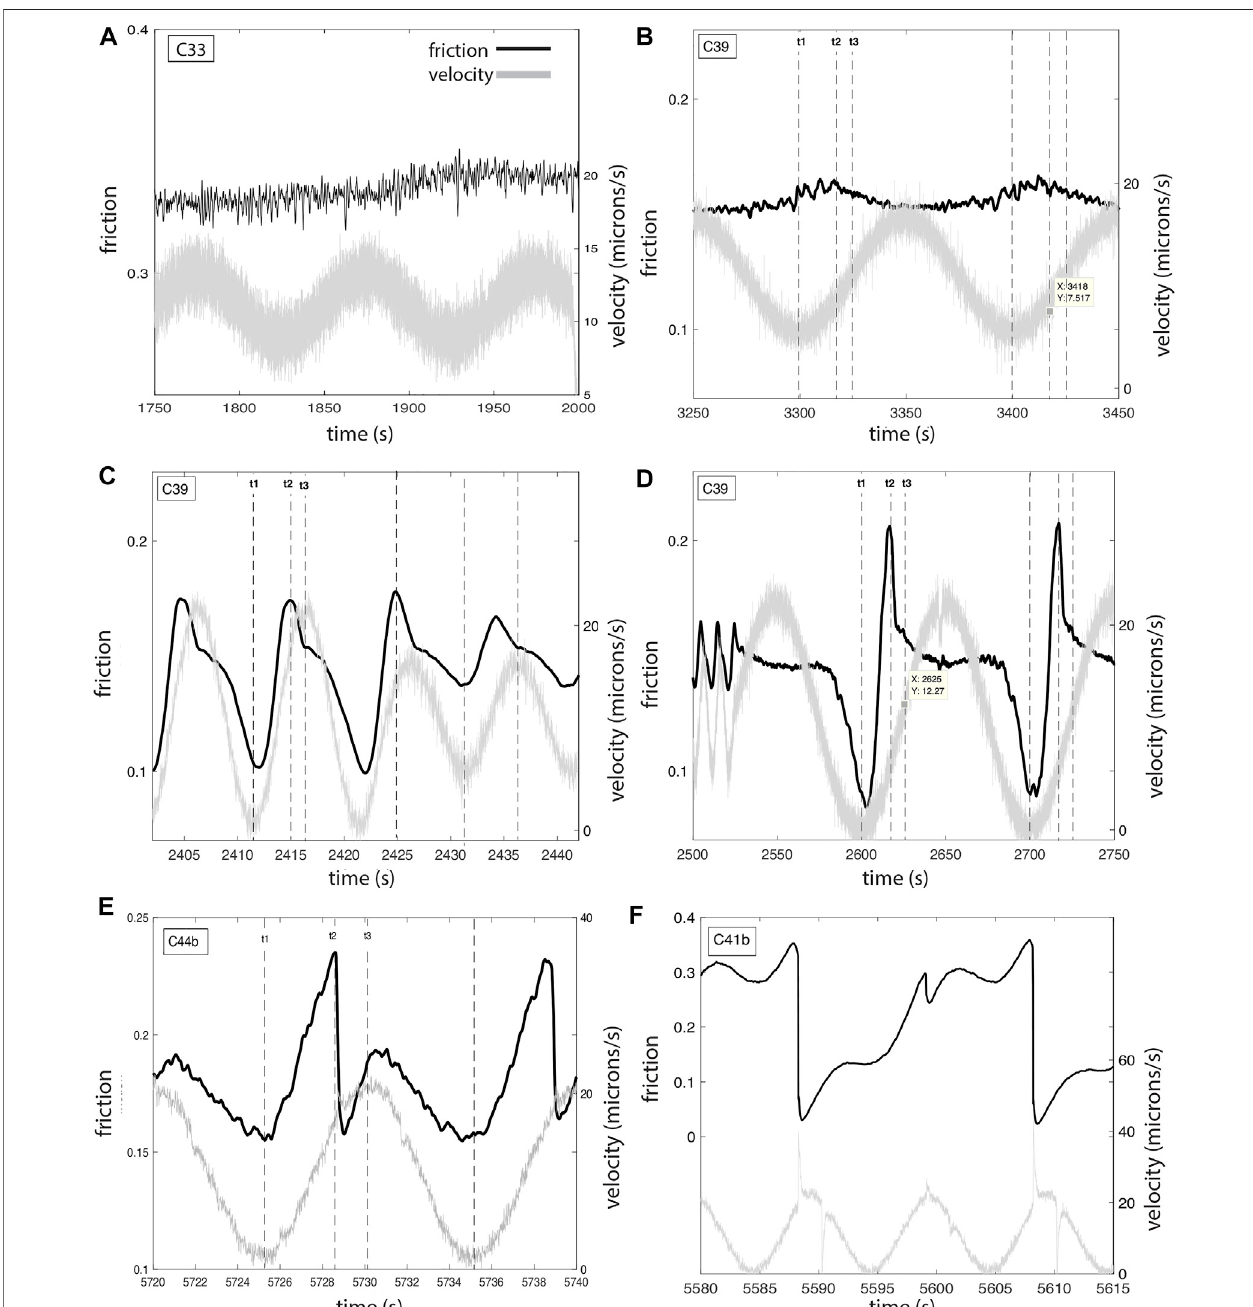
FIGURE 2 | Examples and magni fi cation of different responses observed in the experiments: (A) at long period and small amplitude (20% of Vm) there is no modulation (C33); (B) at long period at 50% of Vm response is slight, with small uptick in friction occurring between the low velocity point (t1) and peak acceleration (t3) (C39); (C) at shorter period (10s) both 100%Vm and 50%Vmare modulated, but not withasimplesinewave (C39); (D) ahigh amplitude event or slow slipevent,which resembles a relaxation hold superimposed on a sine wave (C39); (E) a double event (one fast, one slow) within a single cycle (C44b); (F) pronounced stick-slip events, with almost total stress drop, occurring every other cycle (period doubling) at 1 sec before maximum velocity (C41b).